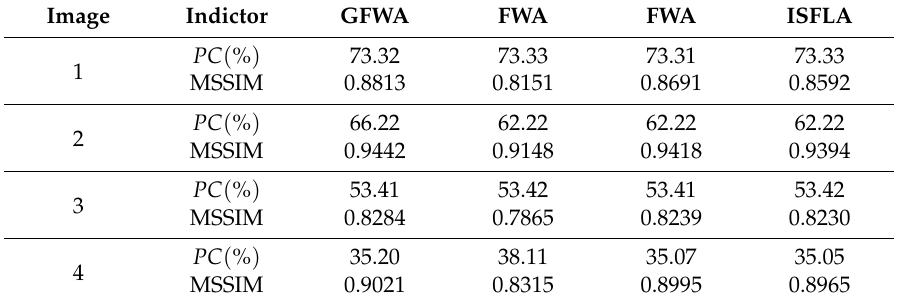
Table 1. The MSSIM index and PC values of the four algorithms. GFWA: Guided Fireworks Algorithm; LUT: Look-Up Table; FWA: Fireworks Algorithm; ISFLA: Improved Shuffled Frog Leaping